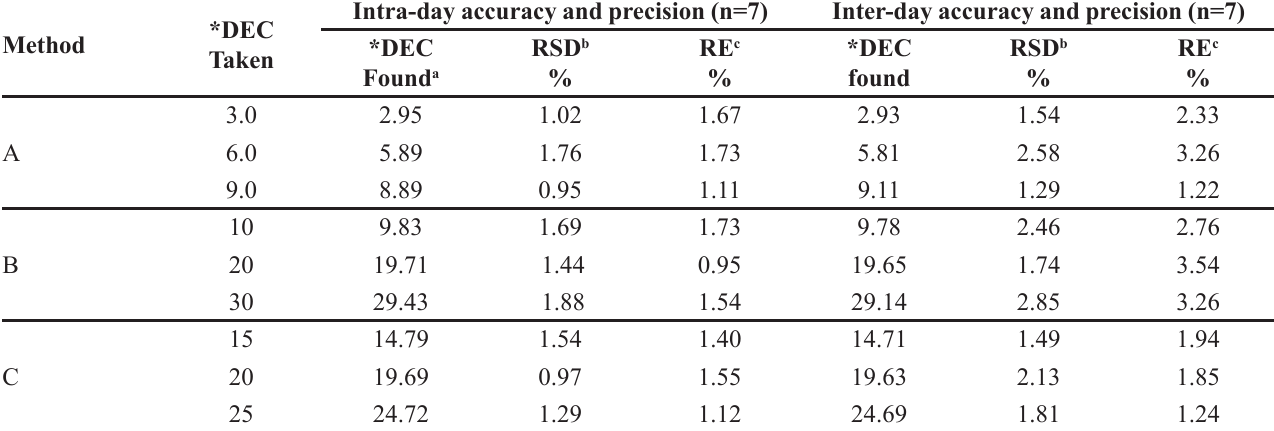
TABLE II - Evaluation of Intra-day and inter-day accuracy and precision